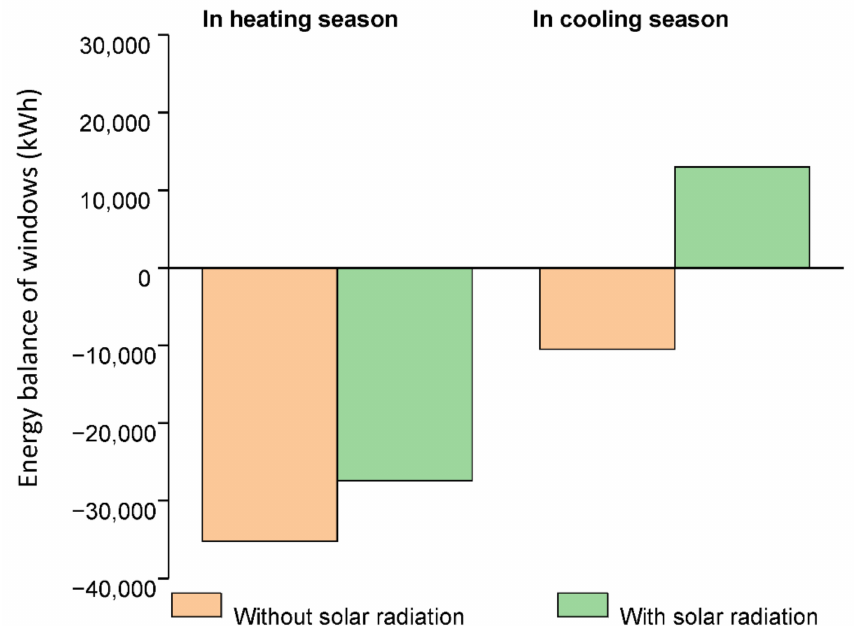
Figure 19. Energy balance of windows with and without solar radiation for case B (with low-E film). In the cooling season, the heat that is lost through the windows is 10,500 kWh ex- cluding the solar radiation; if it is taken into consideration, the windows energy balance corresponds to a heat gain of 13,000